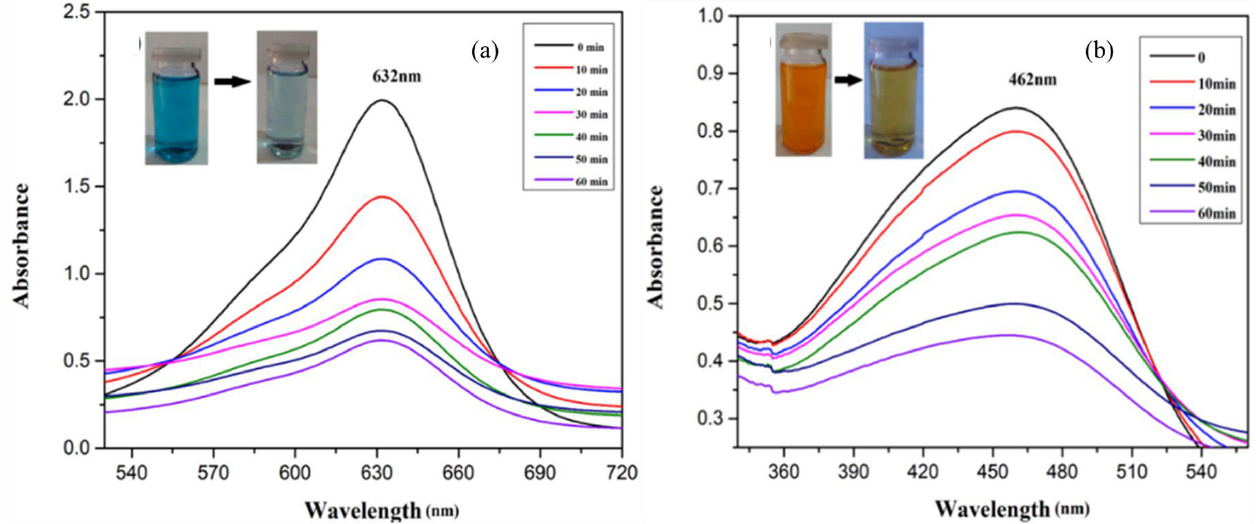
Figure 7. Absorption spectra of the dyes at different time intervals: ( a ) MG, ( b ) MO.